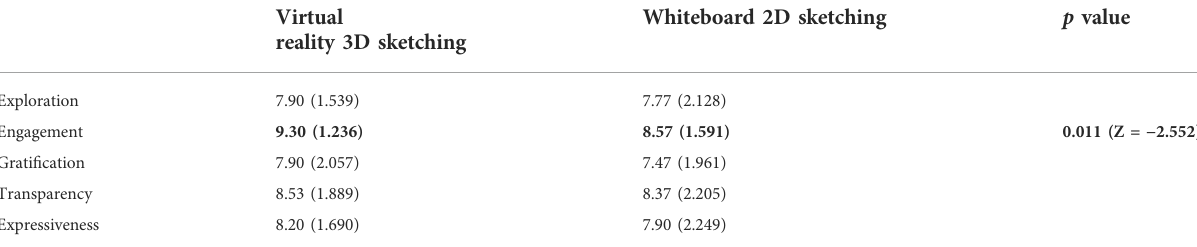
TABLE 3 Means and standard deviations (between brackets) for the fi ve dimensions of the creativity support index concerning the two